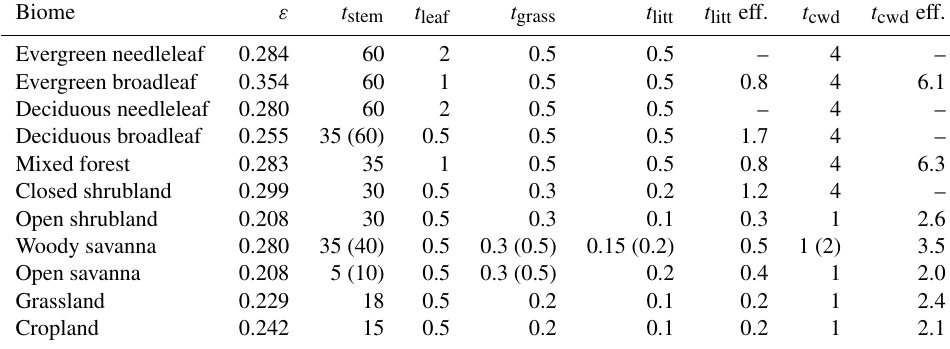
Table 1. Biome-level model parameter values for light-use efficiency (LUE; ε , unitless) and turnover rates ( t , years) for the stem, leaf, grass, litter, and coarse woody debris (cwd) pools. Two additional columns give the average effective turnover rates ( t eff., years) for the litter and cwd pools after scaling by the abiotic scalar. Turnover rates that were different for the 0.25 ◦ resolution model calibration are given in